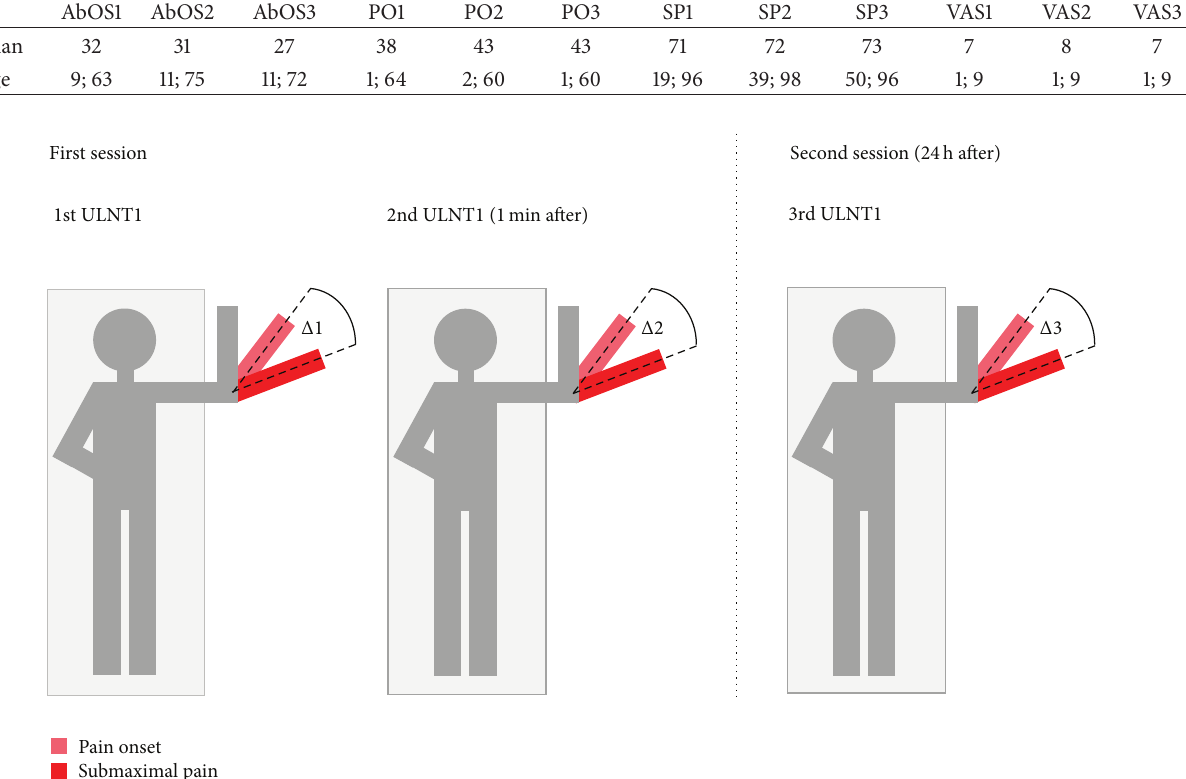
Figure 3: Experimental procedure scheme. The angles of occurrence in range of pain onset and submaximal pain during elbow extension were recorded in each ULNT1; then the angle between PO and SP was calculated for each ULNT1 execution.